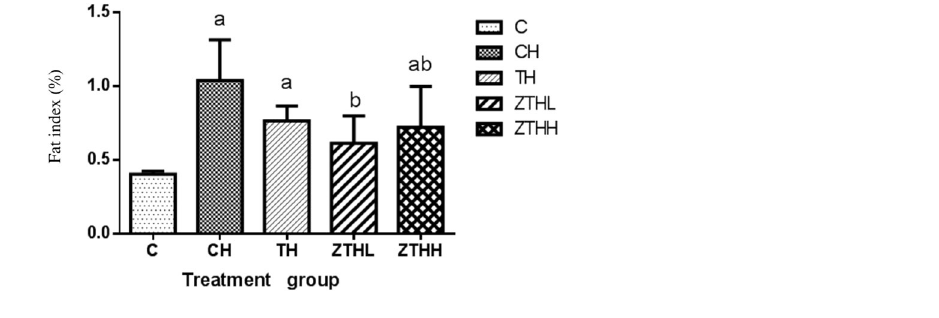
Figure 4. Effect of zinc selenium tea on fat index (%, n = 10, mean and SEM) in experimental groups. a Vs C-group, p < 0.05; b vs CH-group, p <